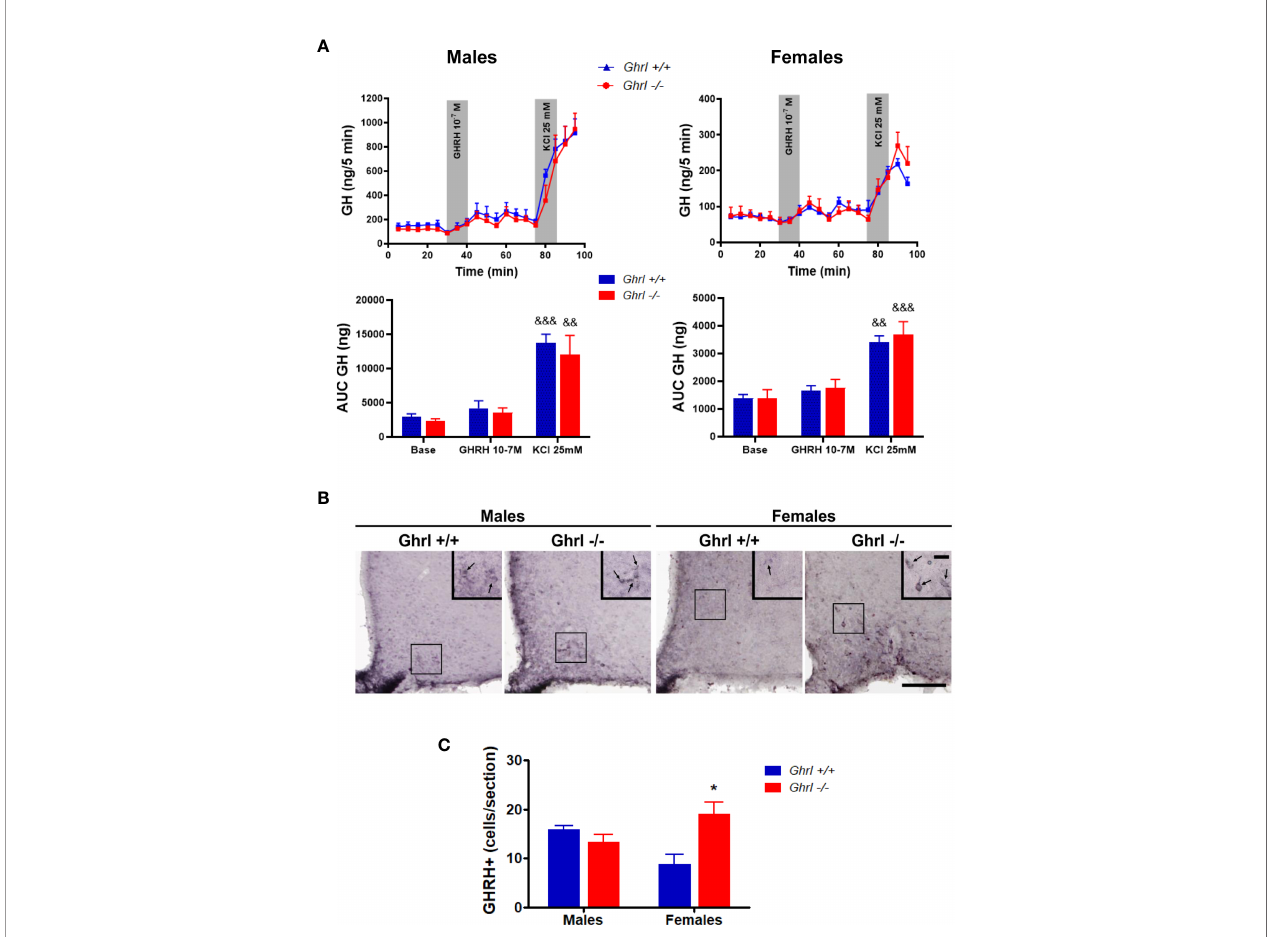
FIGURE 3 | GH release from pituitary explants and GHRH immunoreactivity in the hypothalamus of male and female Ghrl-/- mice. Basal GH release, 10 -7 M GHRH- induced GH release and 25 mM KCl induced GH release measured in adult male and female Ghrl+/+ and Ghrl-/- mice. Note that the Y-axes scales are different for males and females (A) . Photomicrographs of GHRH immunoreactivity staining (B) and GHRH positive cells (C) in the hypothalamus of 36-week-old male and female Ghrl+/+ and Ghrl-/- mice. Data represent mean ± SEM. Number of mice in panel (A) males (n=4 Ghrl+/+ males and 4 Ghrl-/- ), females (n=4 Ghrl+/+ and 4 Ghrl-/- ). Number of mice in panel (C) males (n=3 Ghrl+/+ males and 5 Ghrl-/- ), females (n=5 Ghrl+/+ and 8 Ghrl-/- ) *p < 0.05 Ghrl-/- versus Ghrl+/+ mice of the same sex, && p < 0.01, &&& p <0 .0001 KCl versus base and